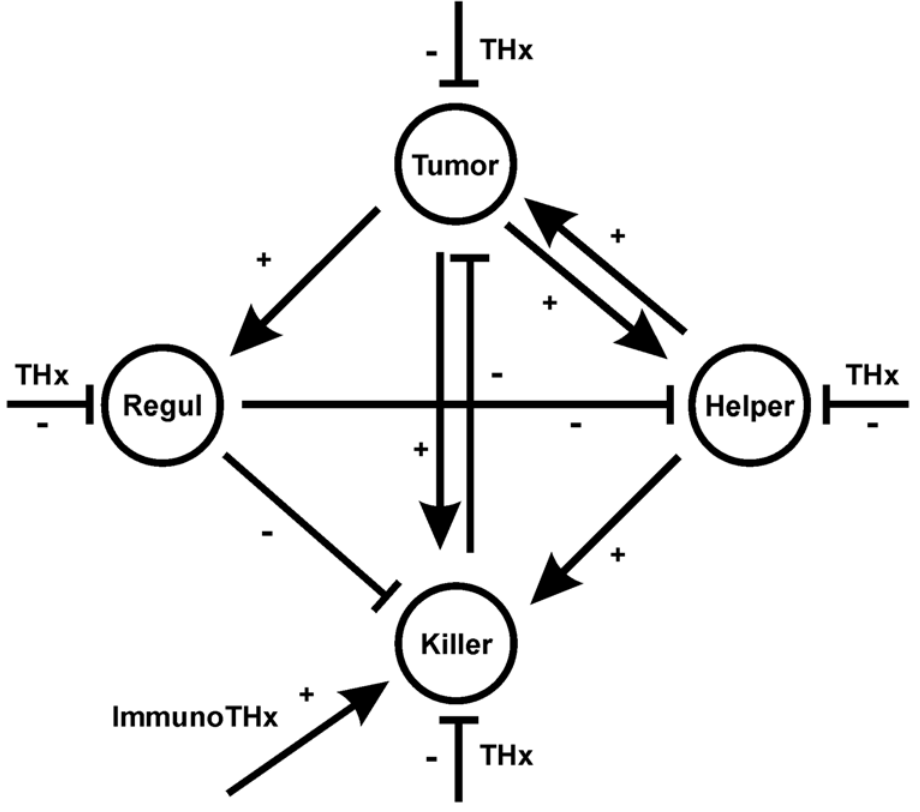
Fig 1. Cellular interactions in the Hodgkin ’ s lymphoma model. The model consists of 4 cell compartments (the tumor cells (Tumor), “ Helper Cells ” (Helper), “ Killer Cells ” (Killer) and “ Regulatory Cells ” (Regul). All compartments can be targeted by cytotoxic therapy (THx). In addition, Immunotherapy (ImmunoTHx) can increase number and activity of killer cells. Tumor cells can stimulate (+) all other cell types. “ Helper Cells ” increase the viability of tumor cells and supply help for “ Killer Cells. ” “ Regulatory Cells ” suppress (-) “ Killer Cells ” as well as “ Helper Cells ” . Finally, “ Killer Cells ” can kill tumor